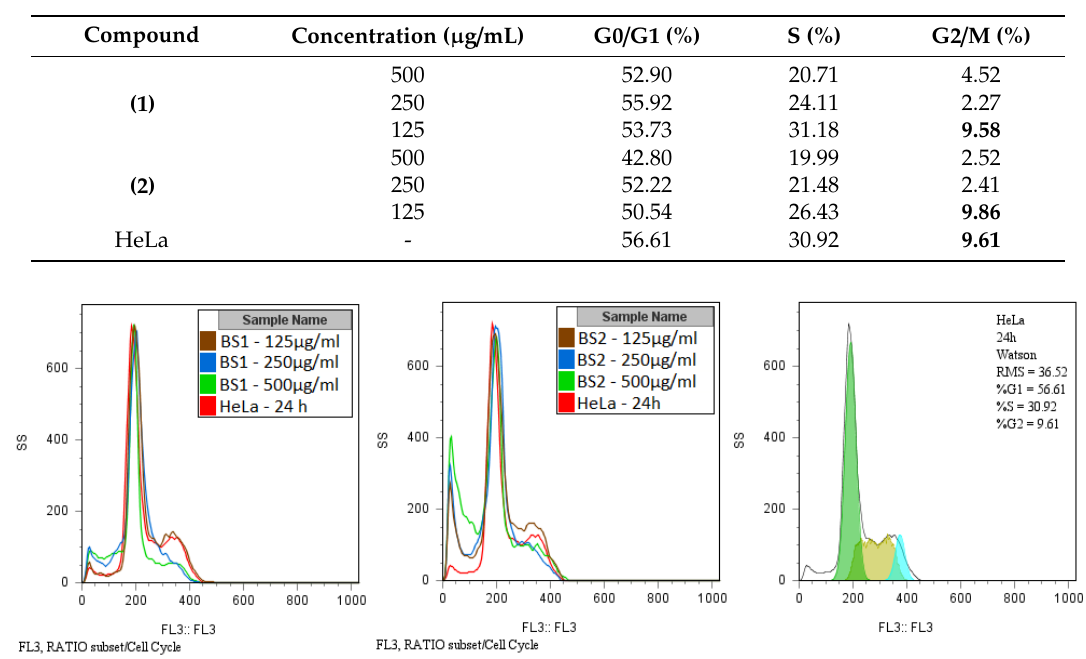
Table 3. The influence of compounds on the cell cycle phases.